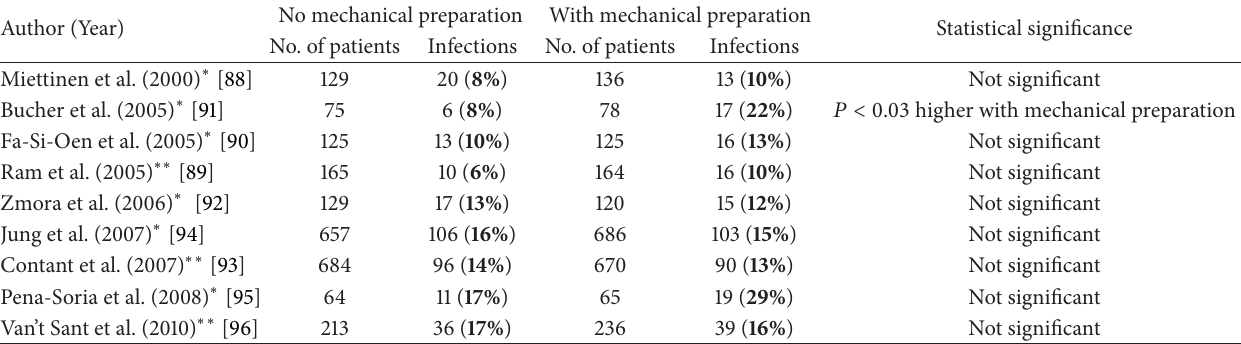
Table 7: A summary of the prospective randomized trials of no mechanical bowel preparation versus patients receiving mechanical bowel preparation in elective colon surgery 2000–2010. Some reports include all surgical site infections ( ∗ ), whereas others include only surgical incision infections ( ∗∗ ). Only one article concludes that there is a statistically significant difference in infection rates, which is higher in mechanically cleansed